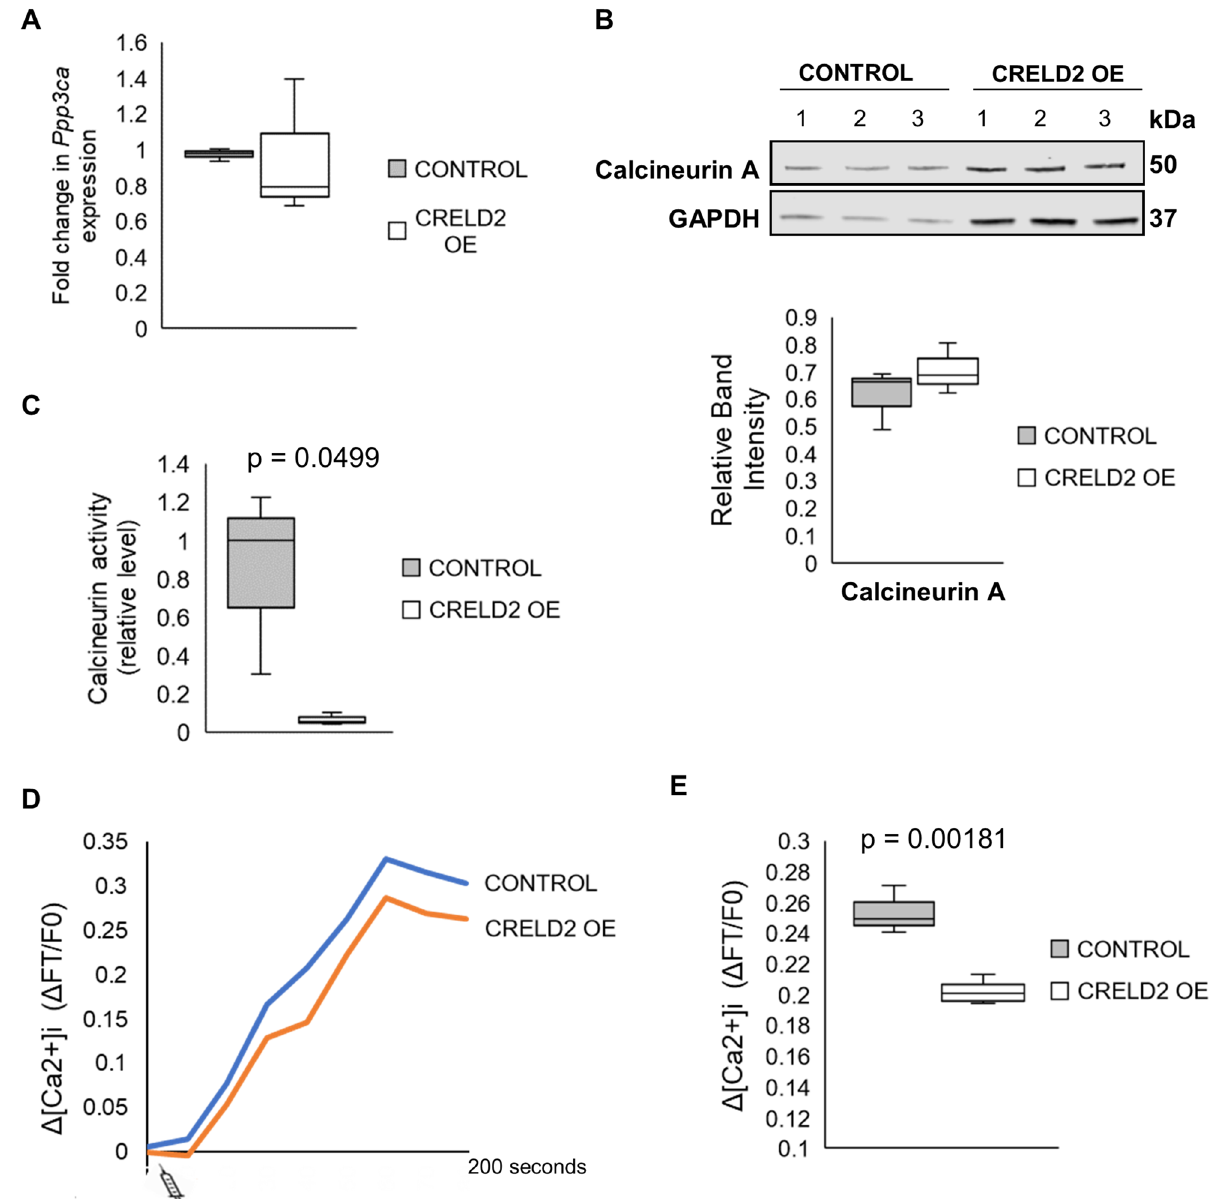
Figure 5. The overexpression of CRELD2 impairs calcium release and reduces Calcineurin activity essential for osteoclastogenesis. ( A ) qPCR-RT analysis and ( B ) Western blot showing Calcineurin A expression in Control and CRELD2 OE osteoclasts 24 h after rRANKL stimulation. ( C ) Cellular calcineurin phosphatase activity in Control and CRELD2 OE osteoclasts 24 h post rRANKL stimulation. ( D ) Calcium release from intracellular stores following thapsigargin treatment in control (Blue line) and CRELD2 OE (Orange line) RAW264.7 cells without RANKL stimulation. ( E ) Calcium release from intracellular stores in Control and CRELD2 OE RAW264.7 cells presented as change in fluorescence (ΔF) relative to basal fluorescence (F0). Gene expression normalised to levels of Actb . Equal loading shown by GAPDH. Levels were determined by band densitometry. n = 3 per sample. Graphs displayed as mean ± SD, significance denoted by p ≤